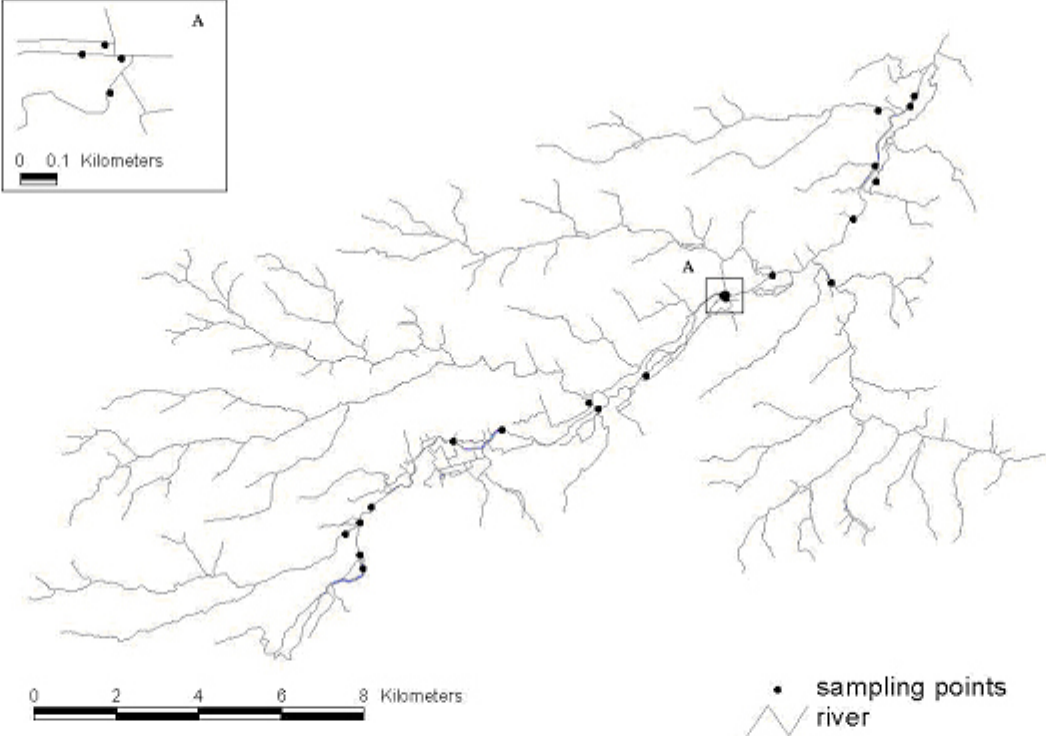
FIGURE 2. Selected sampling sites in the Dender River